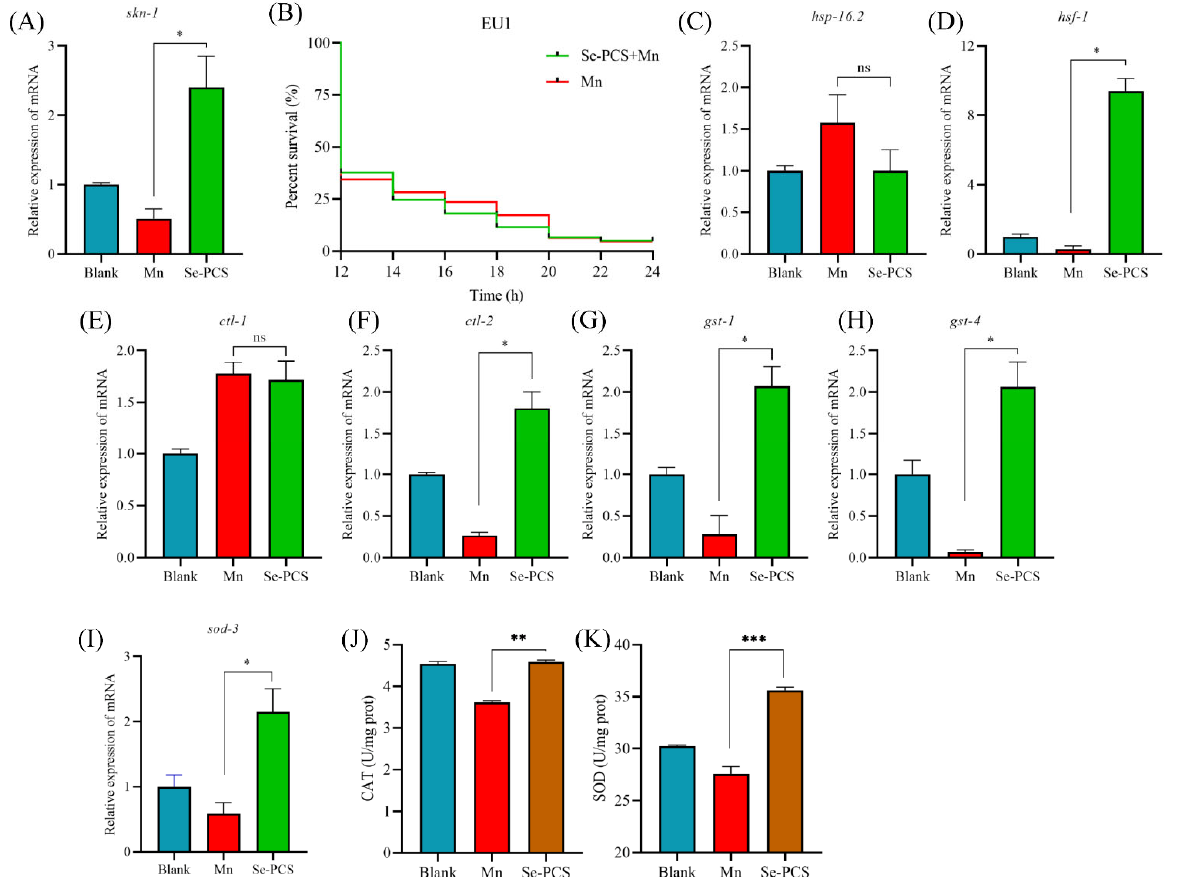
Figure 8. ( A ) The expression of skn ‐ 1 gene and ( B ) survival of EU1 mutant that missed skn ‐ 1 gene. The effect of Se ‐ PCS on the gene expressions involving in defense systems such as ( C ) hsp ‐ 16.2 , ( D ) hsf ‐ 1 , ( E ) ctl ‐ 1 , ( F ) ctl ‐ 2 , ( G ) gst ‐ 1 , ( H ) gst ‐ 4 , and ( I ) sod ‐ 3 . The effect of Se ‐ PCS on the activities of ( J ) CAT and ( K ) SOD. ns means no difference; *, ** and *** mean p < 0.05, p < 0.01 and p < 0.001, respectively, compared with the Mn group.